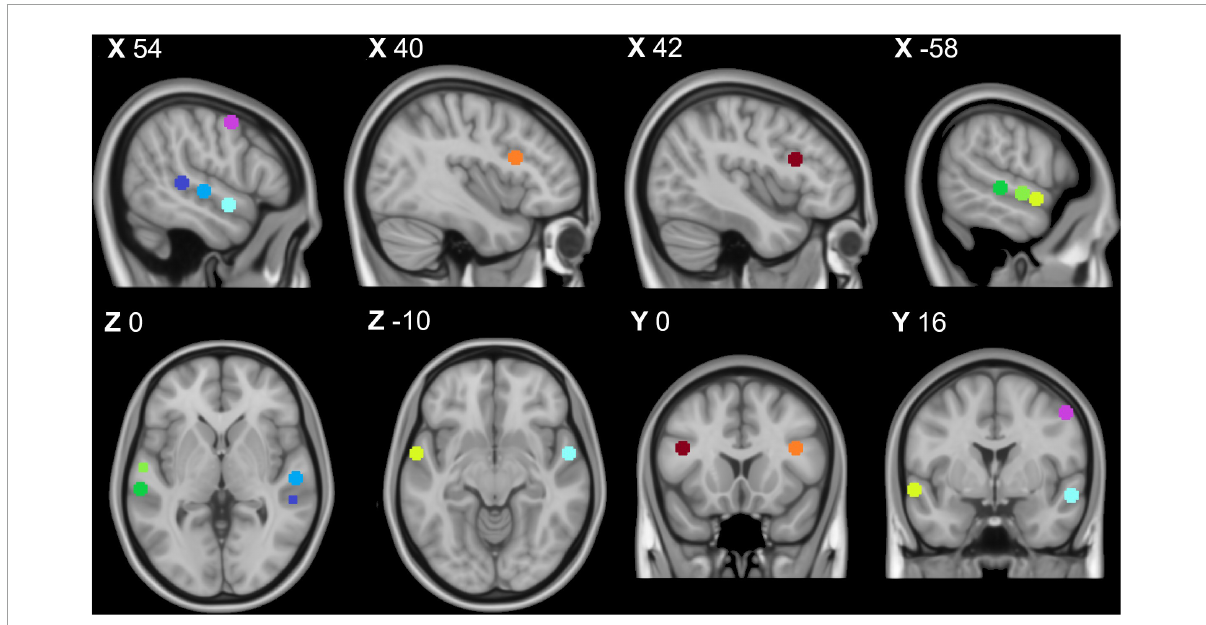
FIGURE1 Temporal voice area fMRI localizer task results: Purple = right premotor cortex, dark blue = right posterior temporal gyrus, middle blue = right middle temporal gyrus, light blue = right anterior temporal gyrus, orange = right inferior frontal cortex, dark green = left posterior superior temporal gyrus, middle green = left middle superior temporal gyrus, light green = left anterior superior temporal gyrus, and red = left inferior temporal cortex. All coordinates listed in MNI space (x,y,z). This image was created using the FSL toolbox fsleyes (McCarthy, 2022).